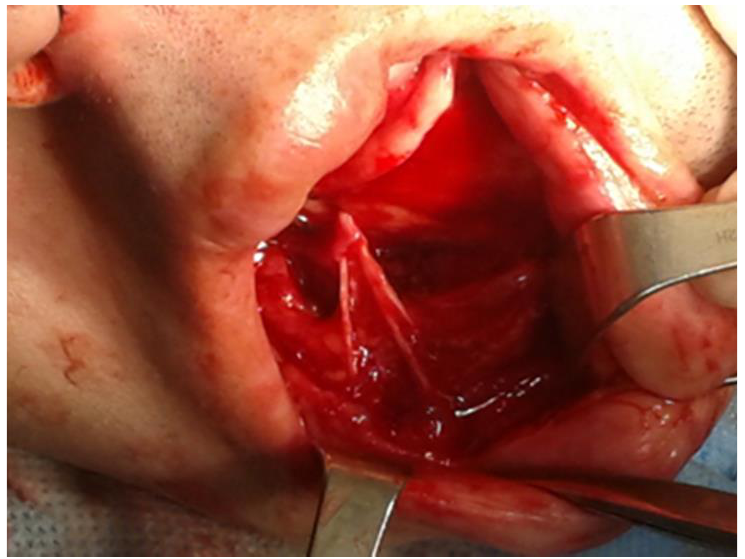
Figure 1. An illustrative figure where the branches of mental nerve are visible during a chin wing osteotomy of the lower border of the mandible during orthognathic surgery. Possible damage of the mental nerve can be caused by various factors, such as trauma (mandibular fracture); endodontic treatment of mandibular premolars and surgery close to this premolar area (iatrogenic factors (cyst removal)); periapical cyst, abscess, and inflam- matory/periapical infections; tumor spread (oral cancer, leukemia, lymphoma (Vincent Sign, tumor spread into the nerve structure)); orthognathic surgery (BSSO-Bilateral Sagittal Split Osteotomy/genioplasty, chin wing approaches); damage to the nerve after abscess drainage; lower lip mucocele removal/labial minor salivary gland retention cyst (nerve fiber damage); local anesthesia administration; compression of the nerve and adjacent tissue pulling; or others [4–10]. These factors might cause transient or permanent paresthe- sia. Mental nerve paresthesia (MNP) is reported to be a cause of dental treatment (dental implant, trauma, endodontic approaches) in approximately 15–20% of cases. On the other hand, according to the Chai et al. study, because of growing interest in the transoral endo- scopic thyroidectomy vestibular approach (TOETVA), many studies indicate that